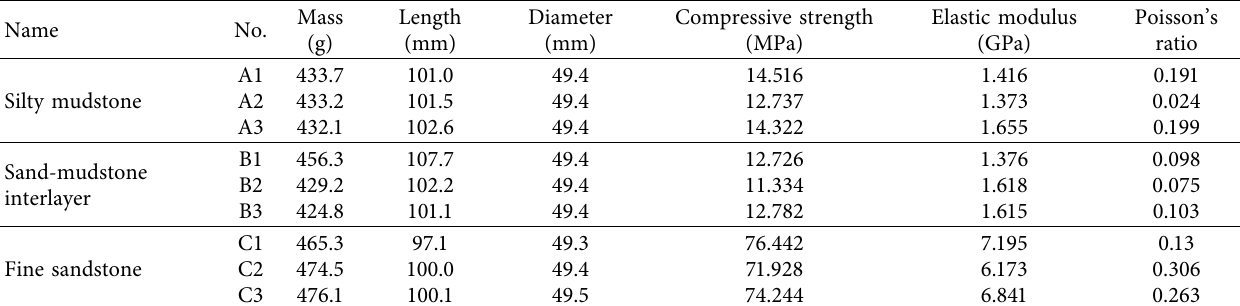
Table 2: Physical and mechanical parameters of each specimen.